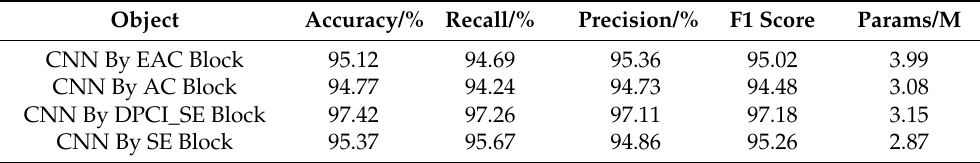
Table 3. Comparison results of the four network